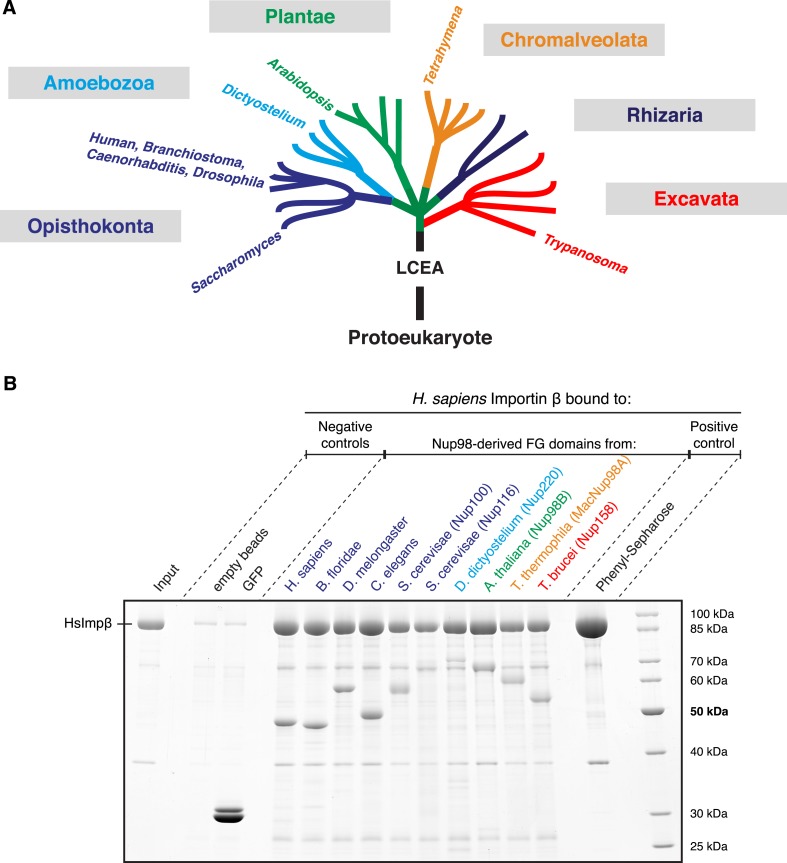
Nup98 FG domains of diverse evolutionary origin bind human Importin β.(A) This study analyses ten Nup98 FG domains from nine species. Cartoon illustrates their positions within the eukaryotic tree of life (adapted from Keeling et al., 2005). See Supplementary file 2 for complete sequences. LCEA denotes the position of the last common ancestor to all eukaryotes. (B) Indicated His-tagged FG domains (30 µg each) were immobilized on 30 µl PEG-passivated Ni(ii) chelate beads and rotated for 2 hr at 4°C with 1 µM untagged human Importin β (400 µl). Bound prey and immobilized baits were co-eluted with SDS/Imidazol and analysed by SDS-PAGE/Coomassie-staining. Note the incomplete elution of the Saccharomyces Nup116 and Dictyostelium Nup220 FG domains. Phenyl-Sepharose served as a positive control (Ribbeck and Görlich, 2002). Binding was in 25 mM Tris/HCl pH 7.5, 100 mM NaCl, 1 mM MgCl2, 0.5% PEG4000, 5 mM DTT.